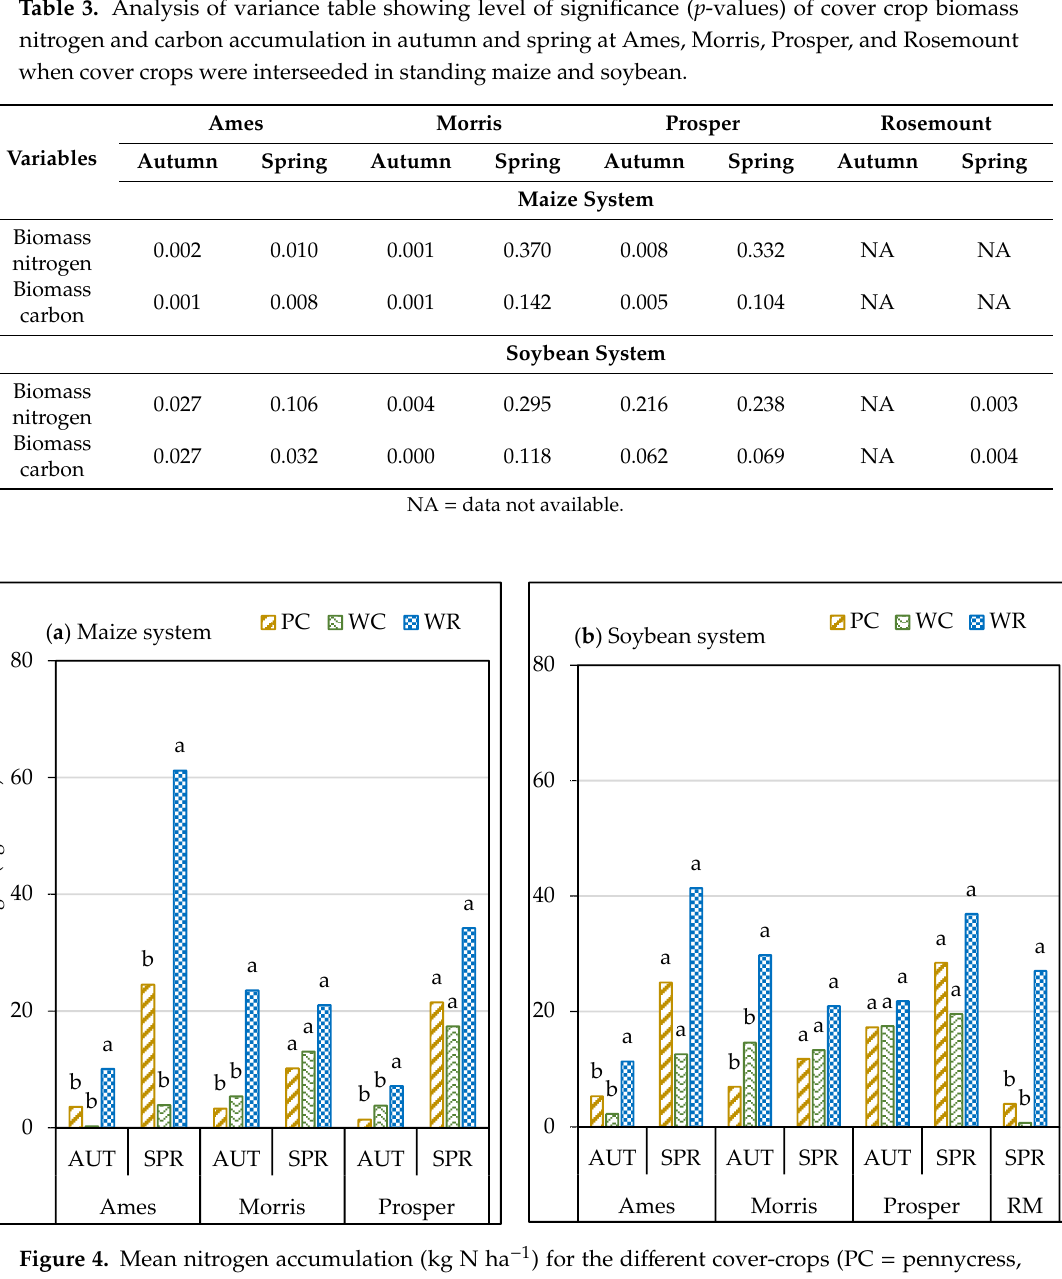
Figure 4. Mean nitrogen accumulation (kg N ha − 1 ) for the di ff erent cover-crops (PC = pennycress, WC = winter camelina, and WR = winter rye) biomass in autumn (AUT) and spring (SPR) at Ames, Morris, Prosper, and RM (Rosemount) when cover crops were interseeded in standing ( a ) maize and ( b ) soybean. Means with same letter within a location and a season for the same system were statistically the same. Data for maize system and in autumn for soybean system for Rosemount (RM) are not available.